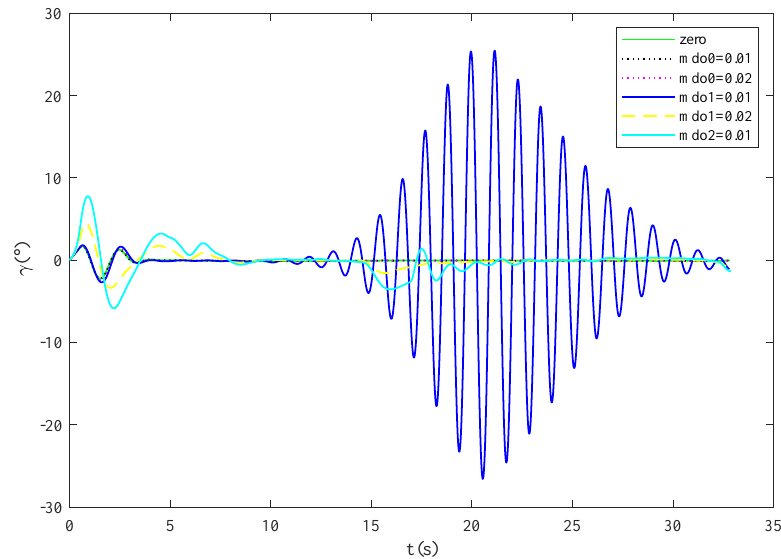
Figure 6. Change curve of roll angle rate under centroid deviation.